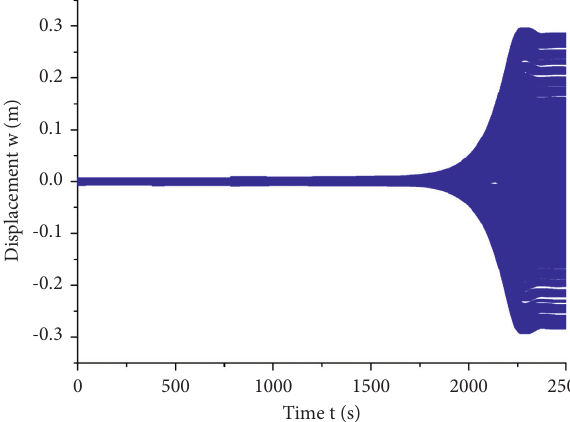
Figure 14: The number of pedestrians on the footbridge. Figure 15: Time history curve of mid-span